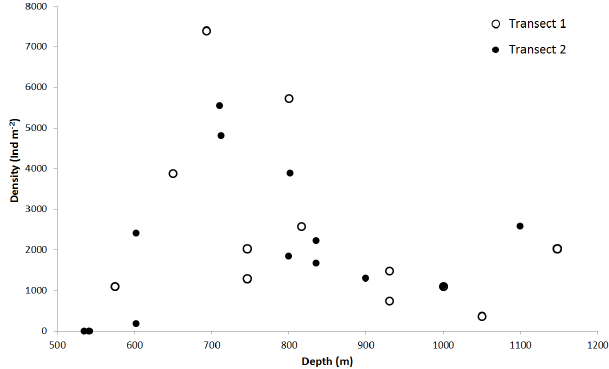
Fig. 3. Metazoan macrofaunal densities in ambient core samples (54cm 2 × 10cm deep) along two transects across the W. Indian margin.